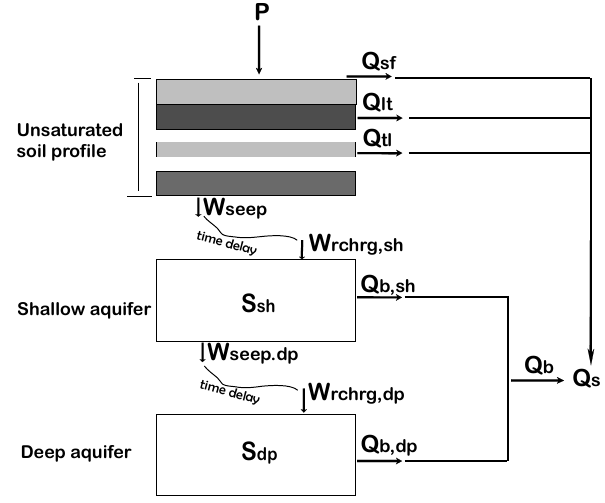
Fig. 1. Schematic of streamflow components in the SWAT model. Note: P is precipitation; Q lt is lateral soil water flow; S sh and S dp are water storages of the shallow and deep aquifer, respectively; other symbols are mentioned within the text.